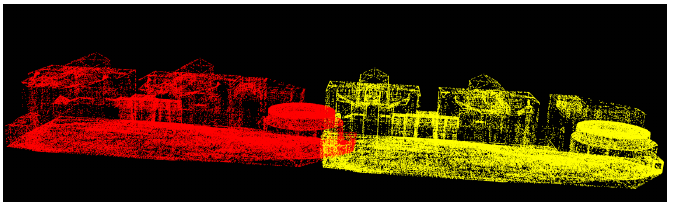
Figure 7. The source point set and target point set for the building model in Figure 6.